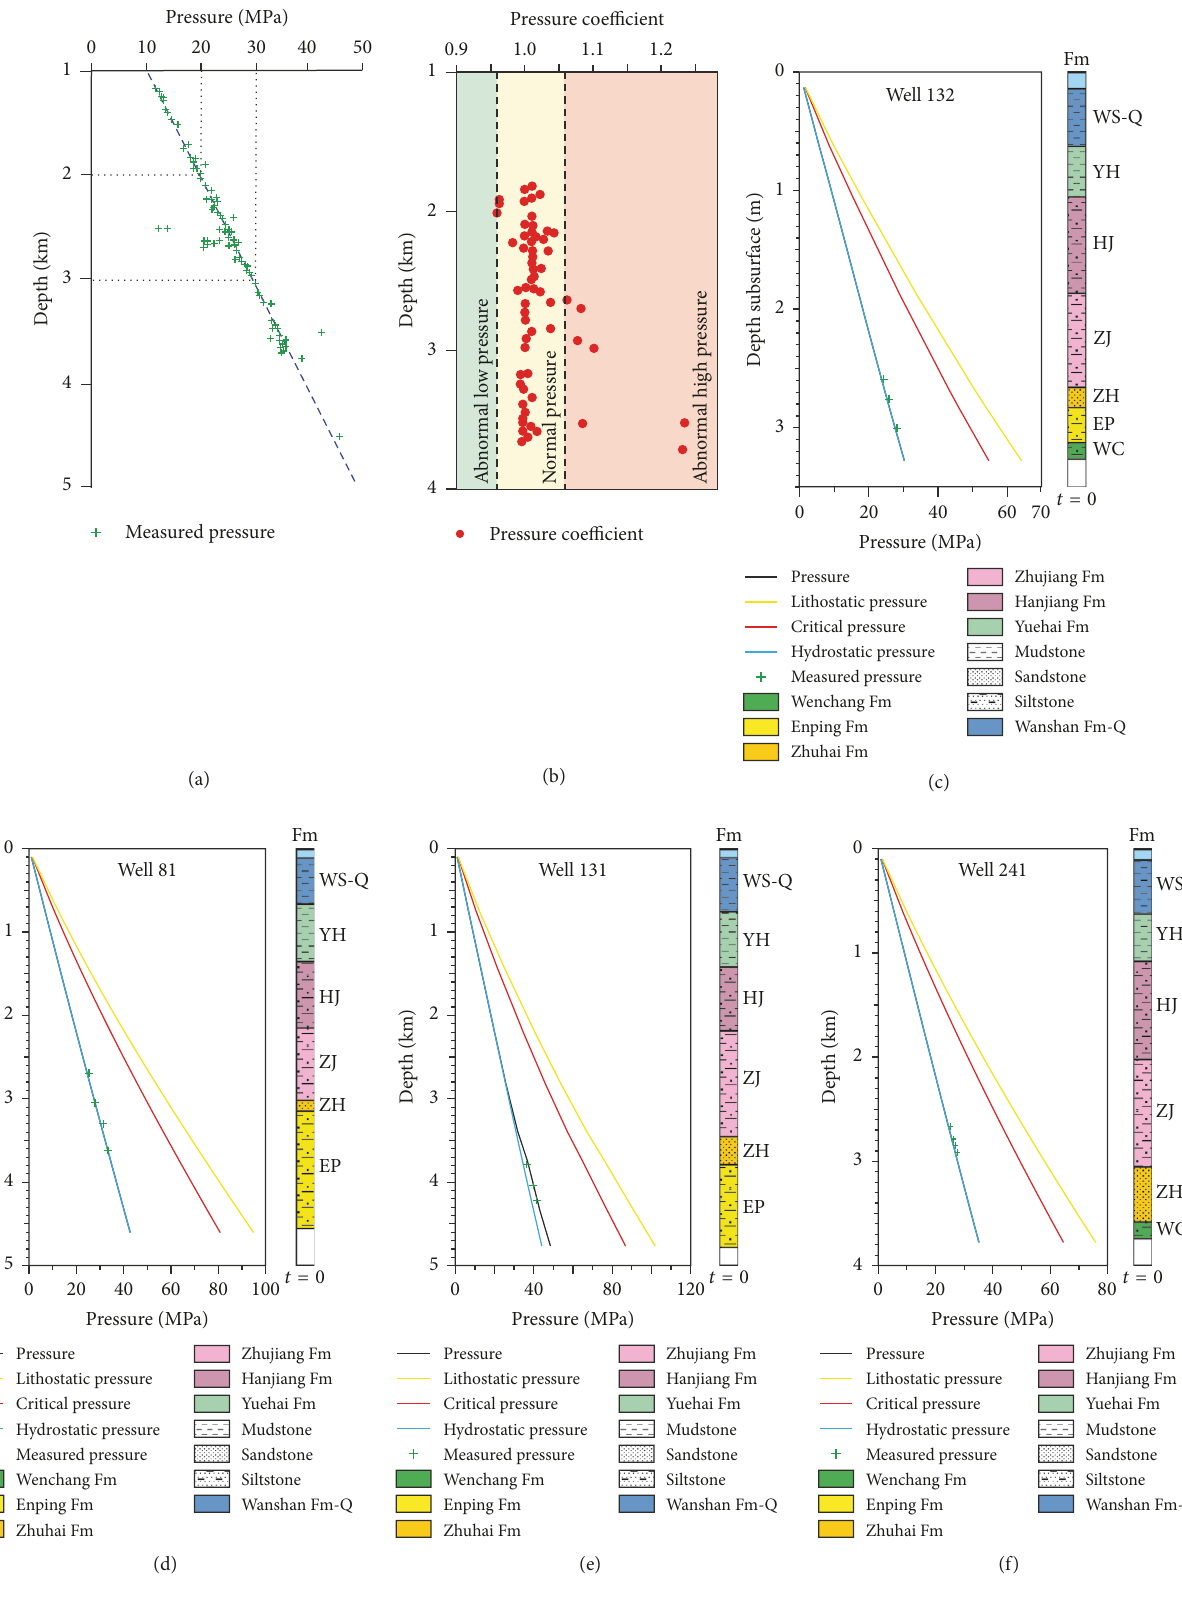
Figure 17: Pressure field (a), pressure coefficient (b), and pressure fitting of wells (c–f) in the Huizhou Sag. The locations of four wells are shown in Figure 1 (formation names: EP = the Enping Fm; ZH = the Zhuhai Fm; ZJ = the Zhujiang Fm; HJ = the Hanjiang Fm; Yh = the Yuehai Fm; WS = the Wanshan Fm; Q =